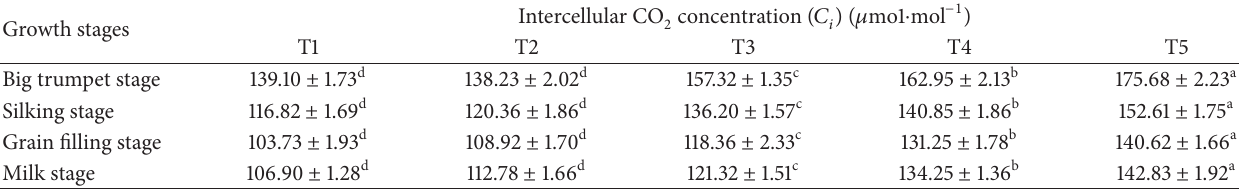
concentration ( 𝐶 𝑖 ) in leaves of 2